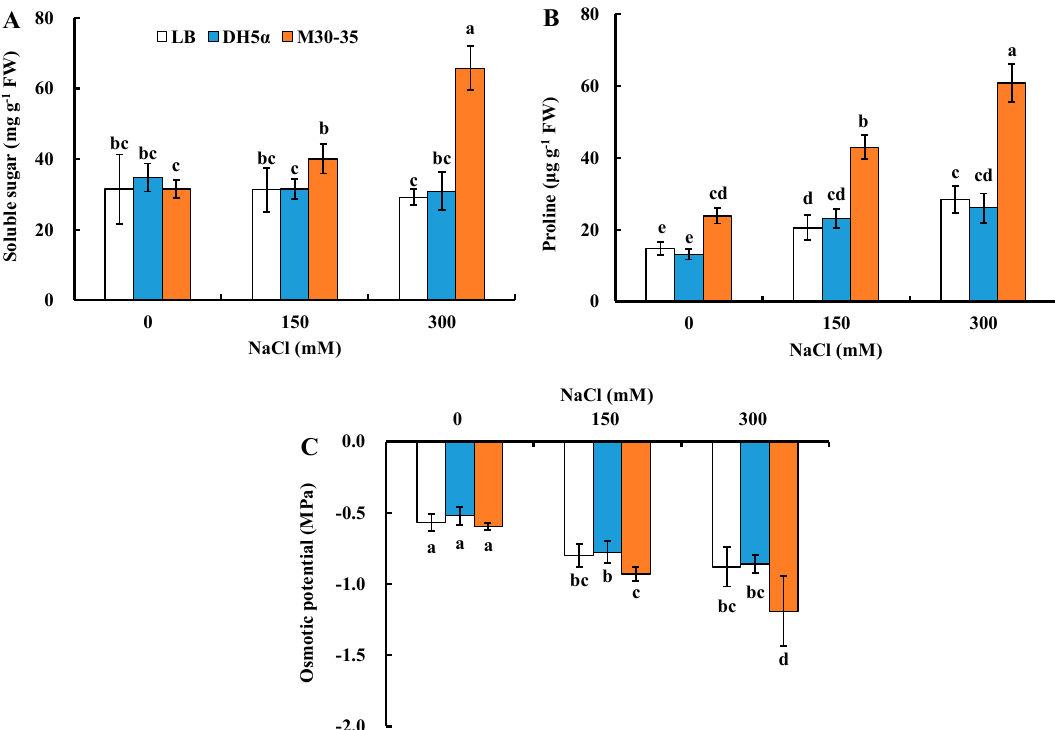
Figure 6. Effects of M30-35 on soluble sugar content ( A ), proline content ( B ) and osmotic potential ( C ) of ryegrass under salt treatment (0, 150 and 300 mM NaCl). Values are means and bars indicate SEs ( n = 12). Columns with different letters indicate significant differences among treatments at p < 0.05 (ANOVA and Duncan’s multiple comparison test).